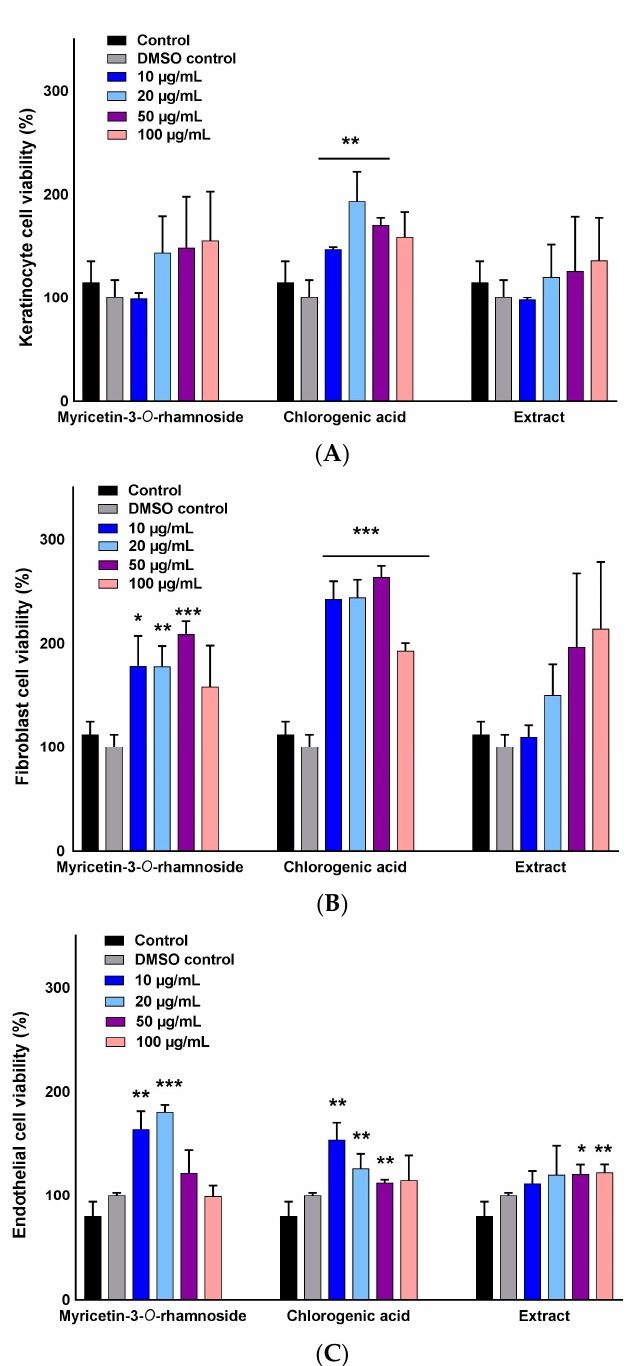
Figure 3. Effect of myricetin-3- O - β -rhamnoside (M), chlorogenic acid (C), and total extract of P. persica (EX) on cell proliferation of ( A ) NHEKs; ( B ) NHDFs; and ( C ) HUVECs. Cell viability (%) was calculated using an MTS assay after 24 h of exposure to various concentrations of the studied compounds. No toxicity was observed in all three cell lines when compared to the control (untreated cells in growth media) and vehicle control (untreated cells in growth media containing control DMSO). Multiple t -tests were performed using Graph-Pad Prism 7.03 to determine the significance between each experimental group and control (* p ≤ 0.05, ** p ≤ 0.01, and *** p ≤ 0.001).